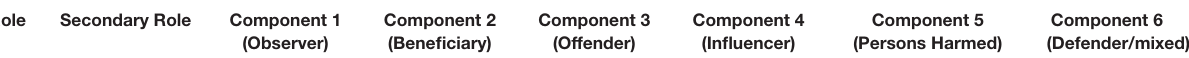
TABLE 3 | Principal components analysis of thirty-five secondary roles for women in wildlife trafficking, according to online survey participants ( n = 215) in February